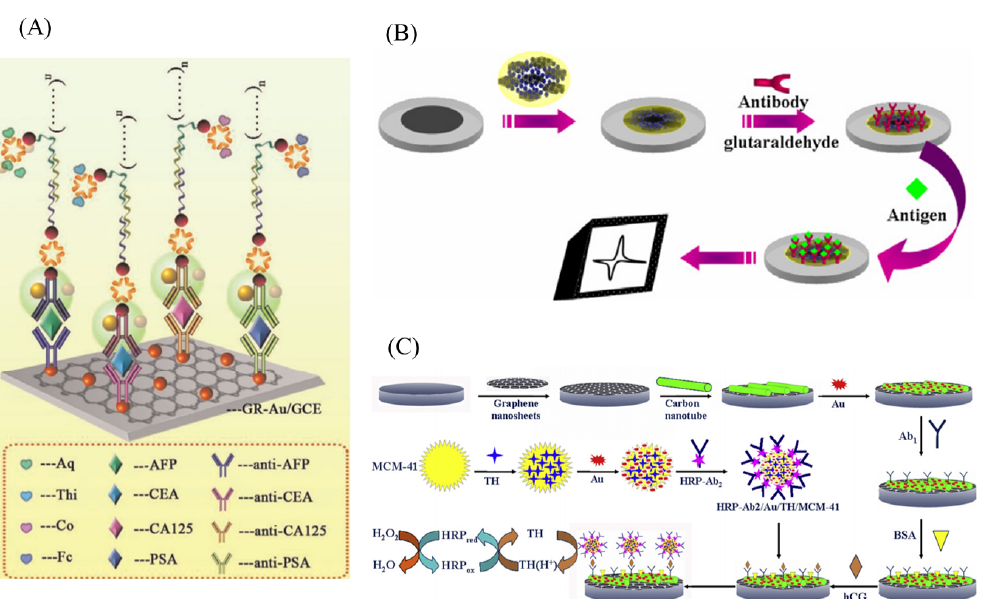
Figure 7. ( A ) Schematic illustration of the principle of sandwich-type simultaneous detection of four antigens. ( B ) Fabrication steps of the label-free electrochemical immunosensor. ( C ) Fabrication process of Au/TH/MCM-41 nanomaterials and the measurement protocol of the electrochemical immunosensor. Figures reproduced with permission from: ( A ) [126], Elsevier c (cid:13) and( C ) [129], Elsevier c . Table 3. Performance of immunosensors based on graphene-based